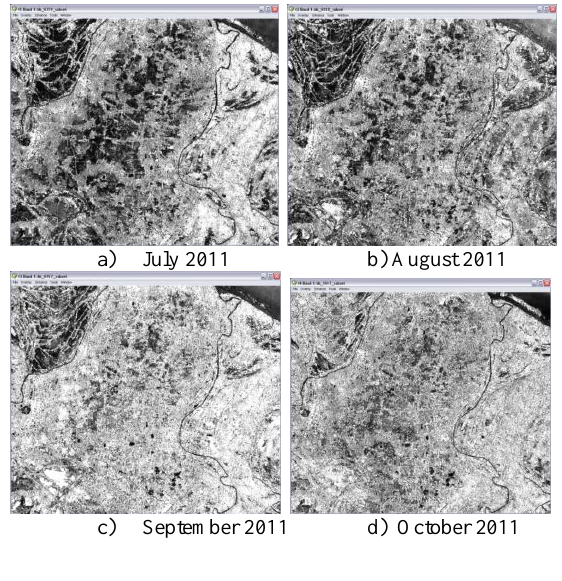
Figure 2. Processed SAR Multi-temporal Images; Color Composites growing season in November, the light green areas represent the forested areas, the pink/purple areas represent the fields where the rice has been harvested, and the blue areas represent